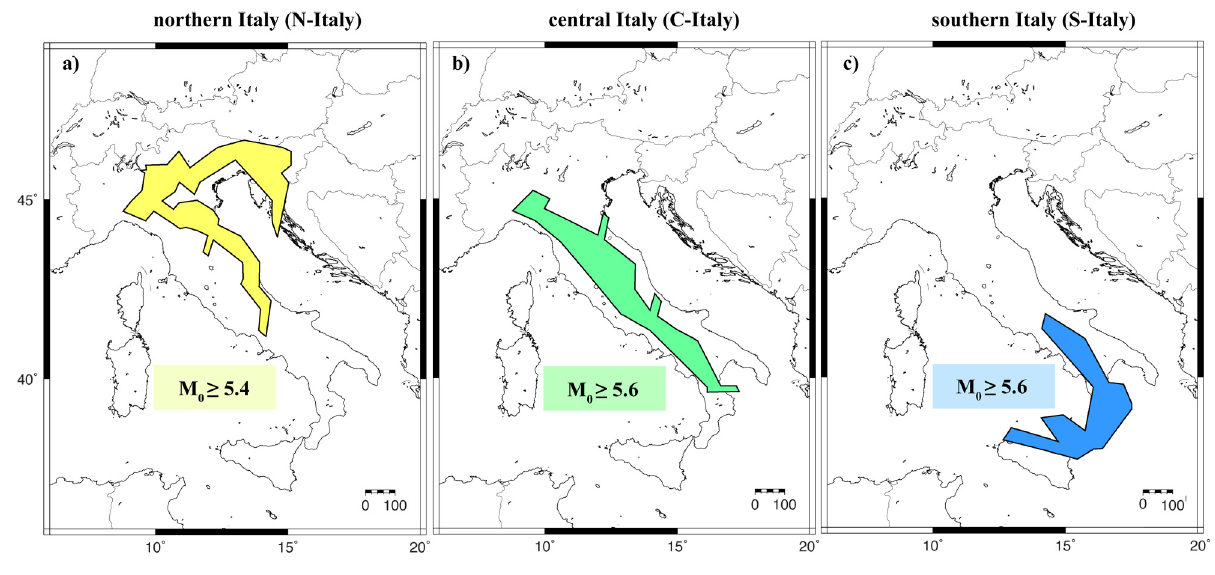
Figure 1. Maps of the three Italian macro-zones related to the regionalization proposed by Peresan et al. [1999]; (a) northern region; (b) is the minimum magnitude for the target earthquakes in each macro-zone (for details on magnitudes central region; (c) southern region. M 0 see Peresan et al.